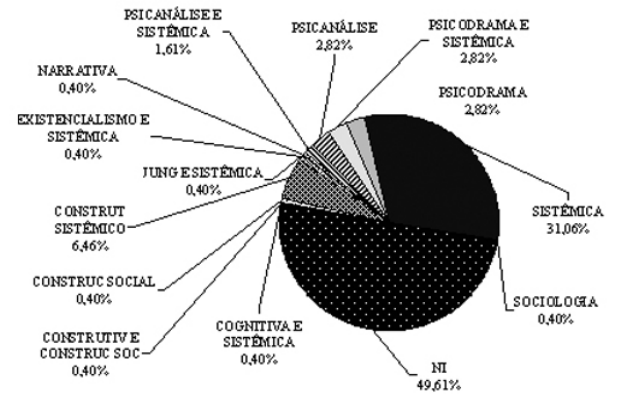
Figura 7. Referências teóricas apresentadas no Caderno de Resumos do III Congresso Brasileiro de Terapia de